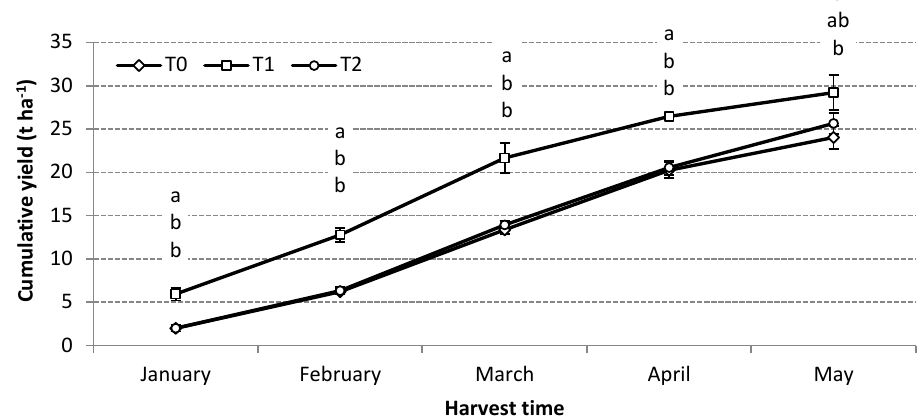
Figure 4. Cumulative yield evolution according to the cuttings type used for the artichoke vegetative propagation. Within the same period, data were analyzed by ANOVA and values with no letter in common are significantly different at p < 0.05 according to Tukey’s HSD Test. Standard errors are reported. T0: summer ovoli; T1: spring offshoots nursery’s cuttings forced to pass a vegetative rest period by stopping irrigation; T2: spring offshoots nursery’s cuttings not forced.